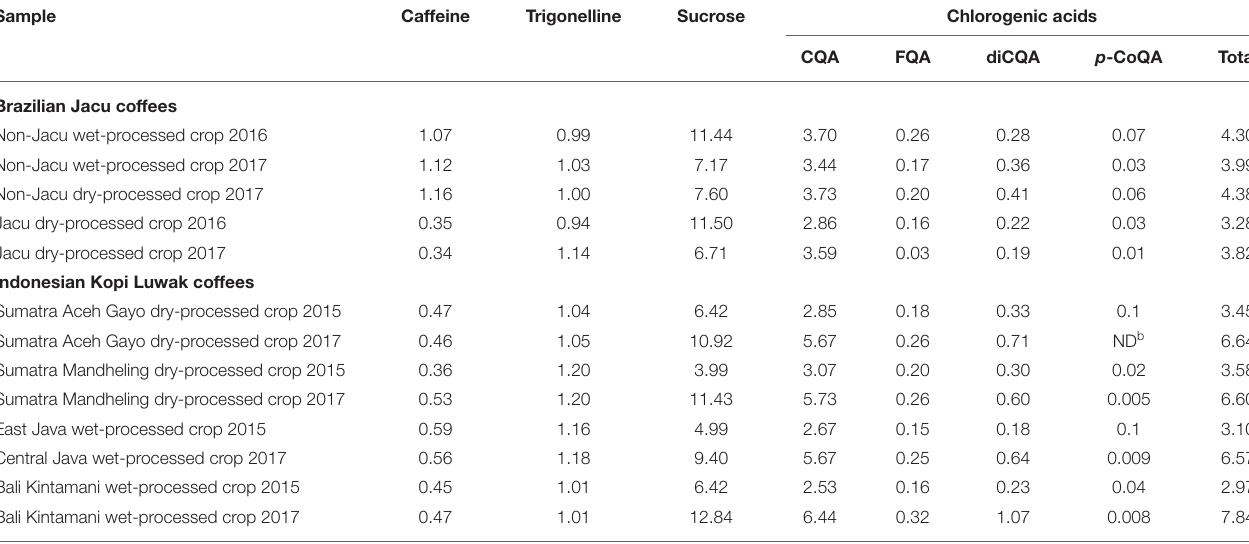
TABLE 3 | Caffeine, trigonelline, sucrose and chlorogenic acids contents (g/100g dry weight) in non-Jacu, Jacu and Kopi Luwak coffee samples a . Sample